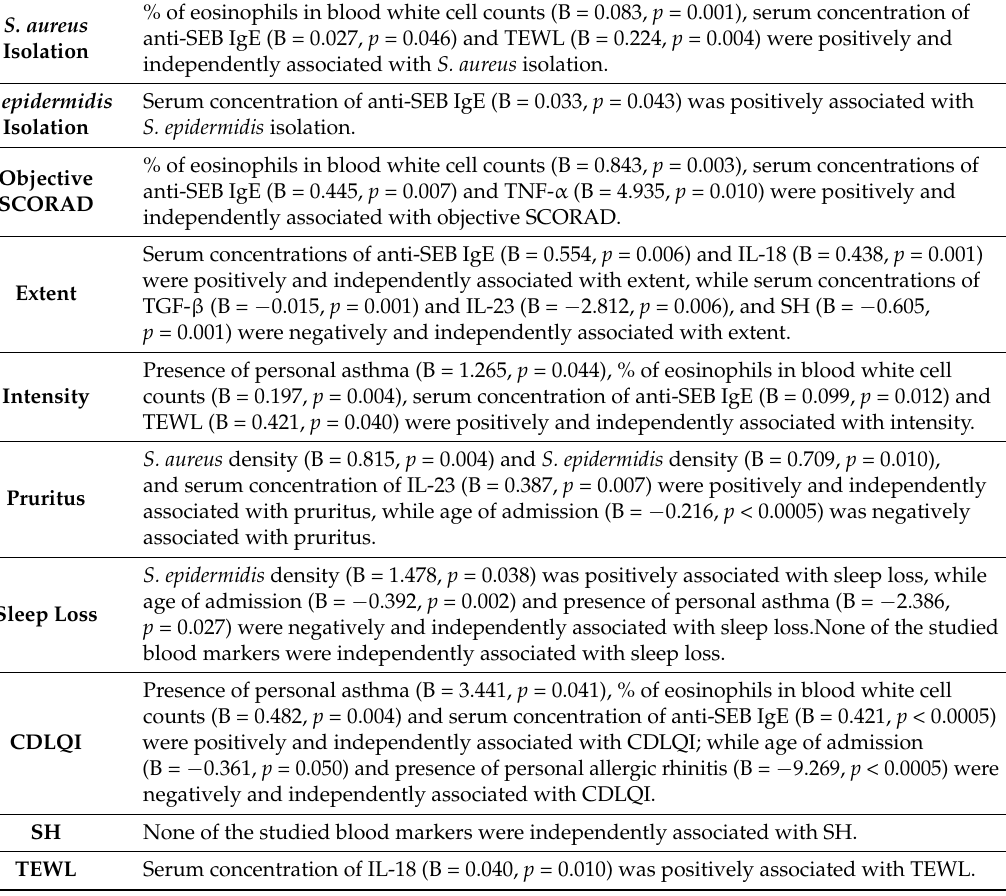
Table 4. Results of backward stepwise linear regression (controlling for age of admission, personal allergic rhinitis and asthma, and other blood markers that had rho ≤− 0.2 or ≥ 0.2 with the clinical index).